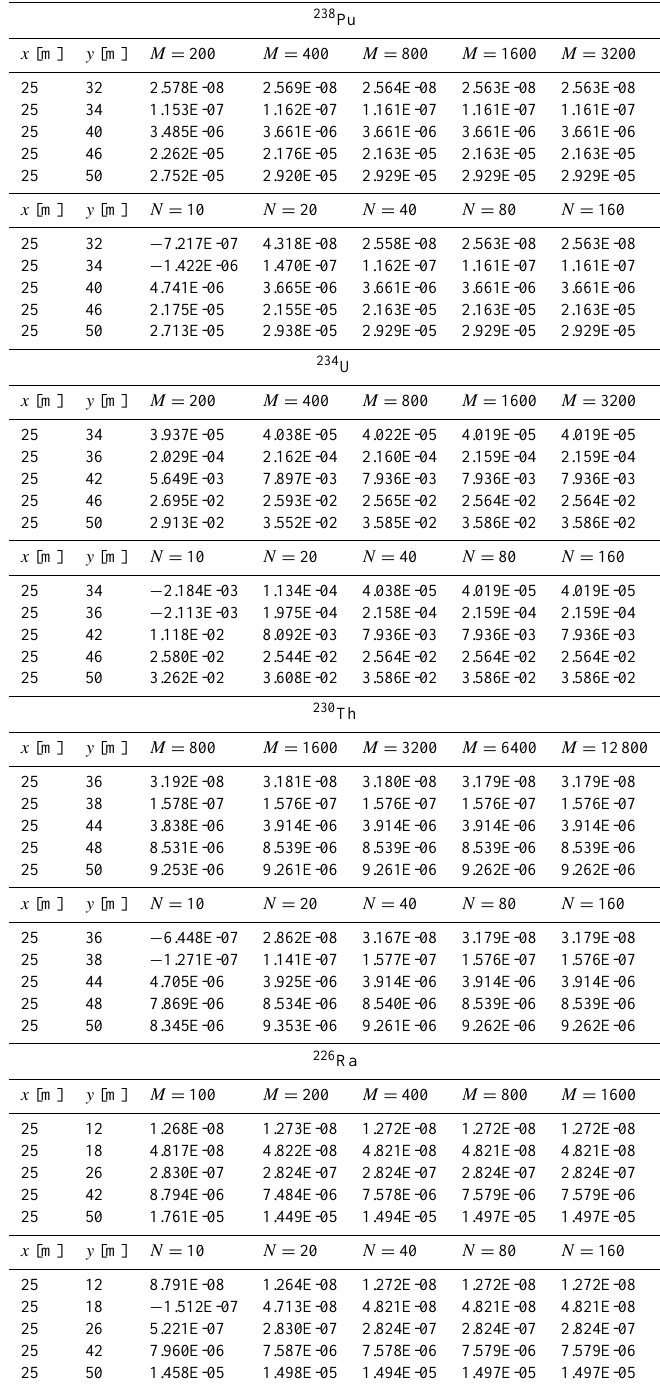
Table 7. Solution convergence of each species concentration at transect of x = 250 m for four-species radionuclide transport problem con- sidering simulated domain of L = 2500m, W = 100 m subject to Bateman-type sources located at 45m ≤ y ≤ 55m for t = 1000years ( M = number of terms summed for inverse generalized integral transform; N = number of terms summed for inverse finite Fourier cosine transform). When we investigate the required M for inverse generalized integral transform, N = 160 for the finite Fourier cosine transform inverse are used. When we investigate the required N for inverse finite Fourier cosine transform, M = 12800 for the generalized transform inverse are